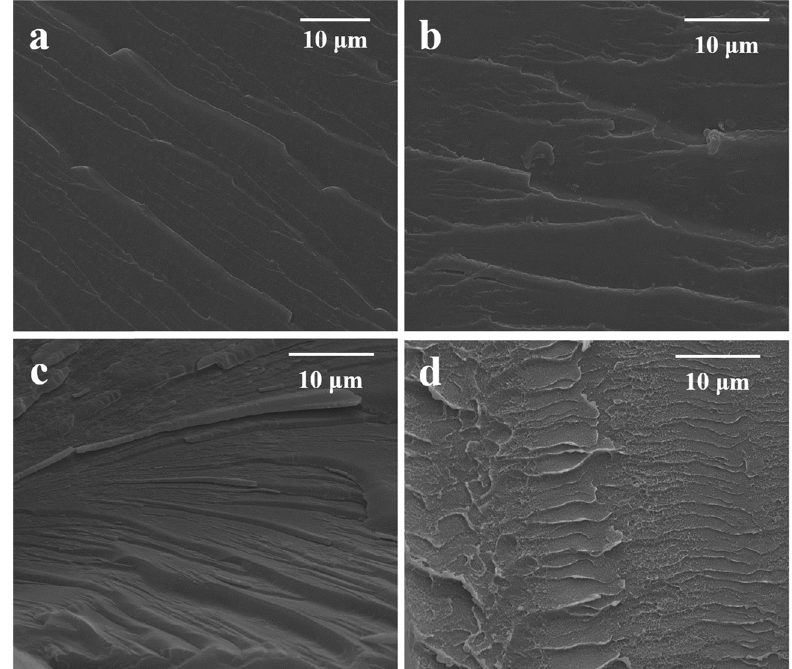
Figure 10: The SEM images of the fractured surfaces of EP/PAA after curing: ( a ) E 1 , ( b ) E 2 , ( c ) E 3 , and ( d ) E 6